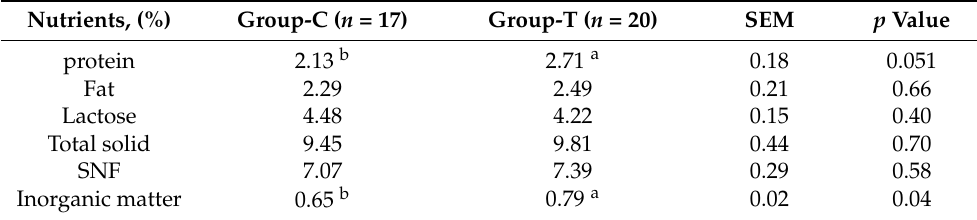
Table 2. Camel milk’s nutritive value raised under semi-intensive system during